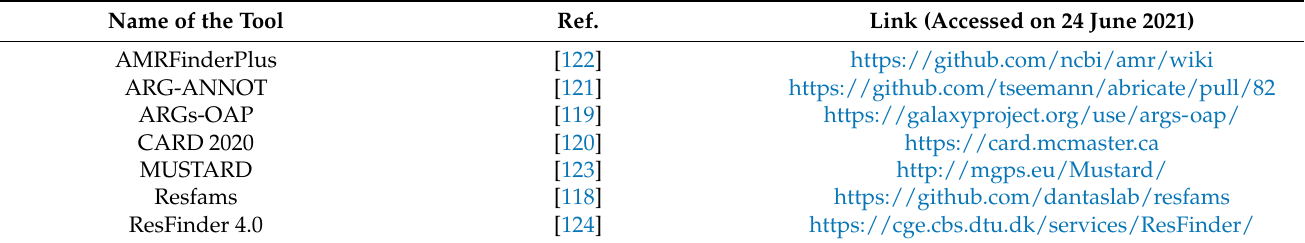
Table 1. Bioinformatics databases of antibiotic resistance